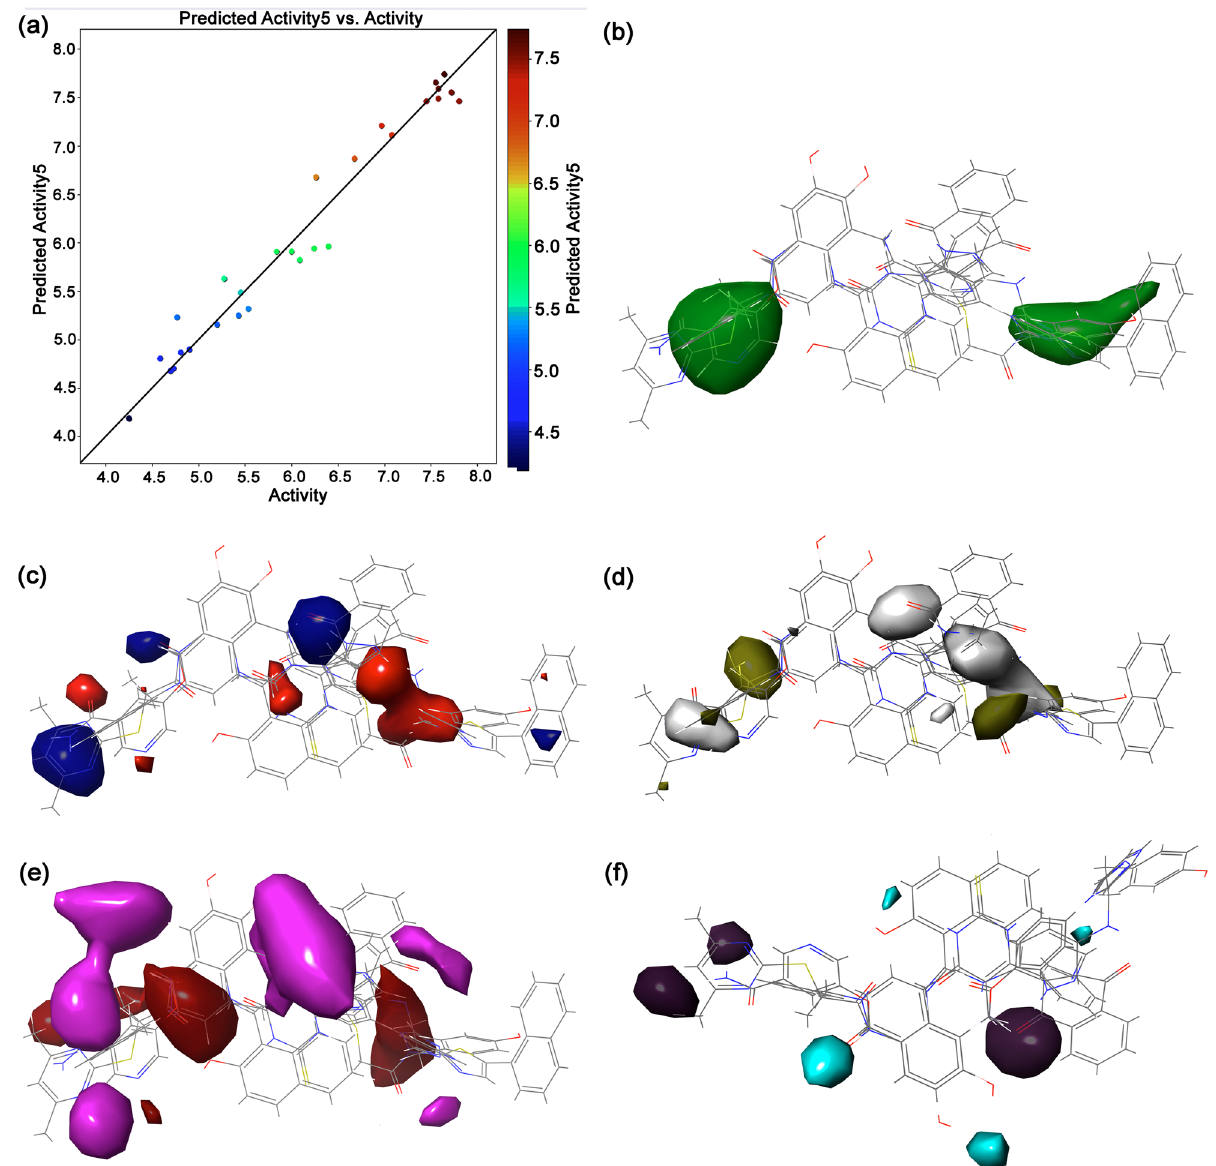
Figure 11. Field Based 3D-QSAR model development for the known selective inhibitors of Sirt2; ( a ) scatter plot exhibiting experimental versus predicted activities of the training set, ( b ) Gaussian sterric ( c ) Gaussian electrostatic, ( d ) Gaussian hydrophobic, ( e ) Gaussian hydrogen acceptor, ( f ) Gaussian hydrogen donor, counter surface maps plotted on the aligned ligands. Academic Schrödinger-Maestro v12.0 suite 35 was used to renders the images (URL: https:// www. schro dinger.